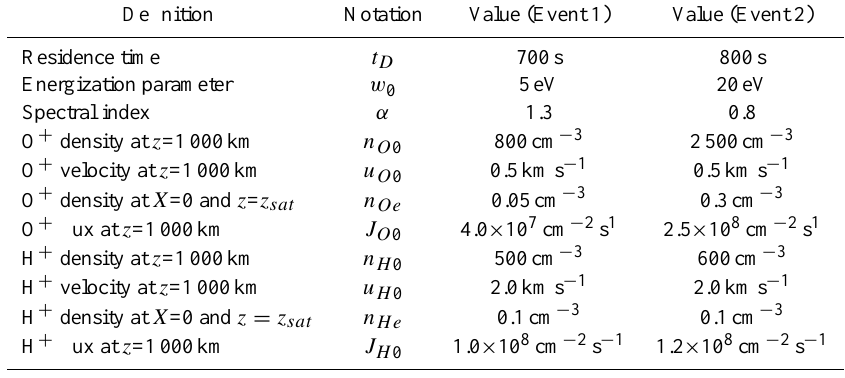
Table 2. List and values of parameters used as input to numerical simulations that have been applied to events 1 and 2